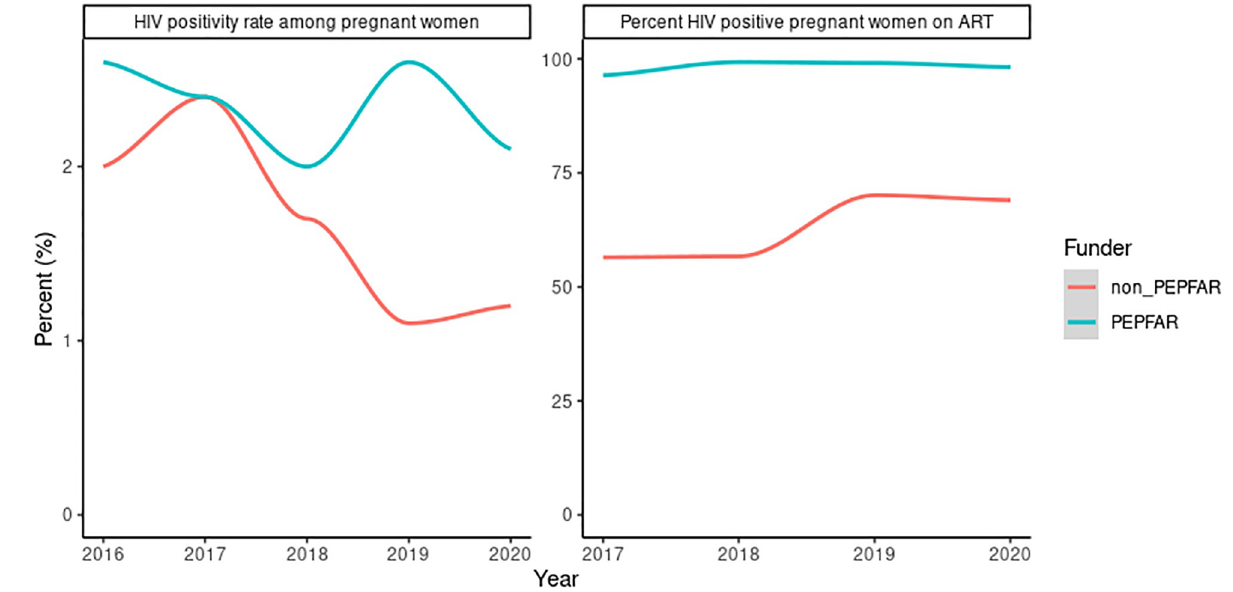
Fig 12. HIV positivity rate and percent of HIV positive pregnant women on ART by